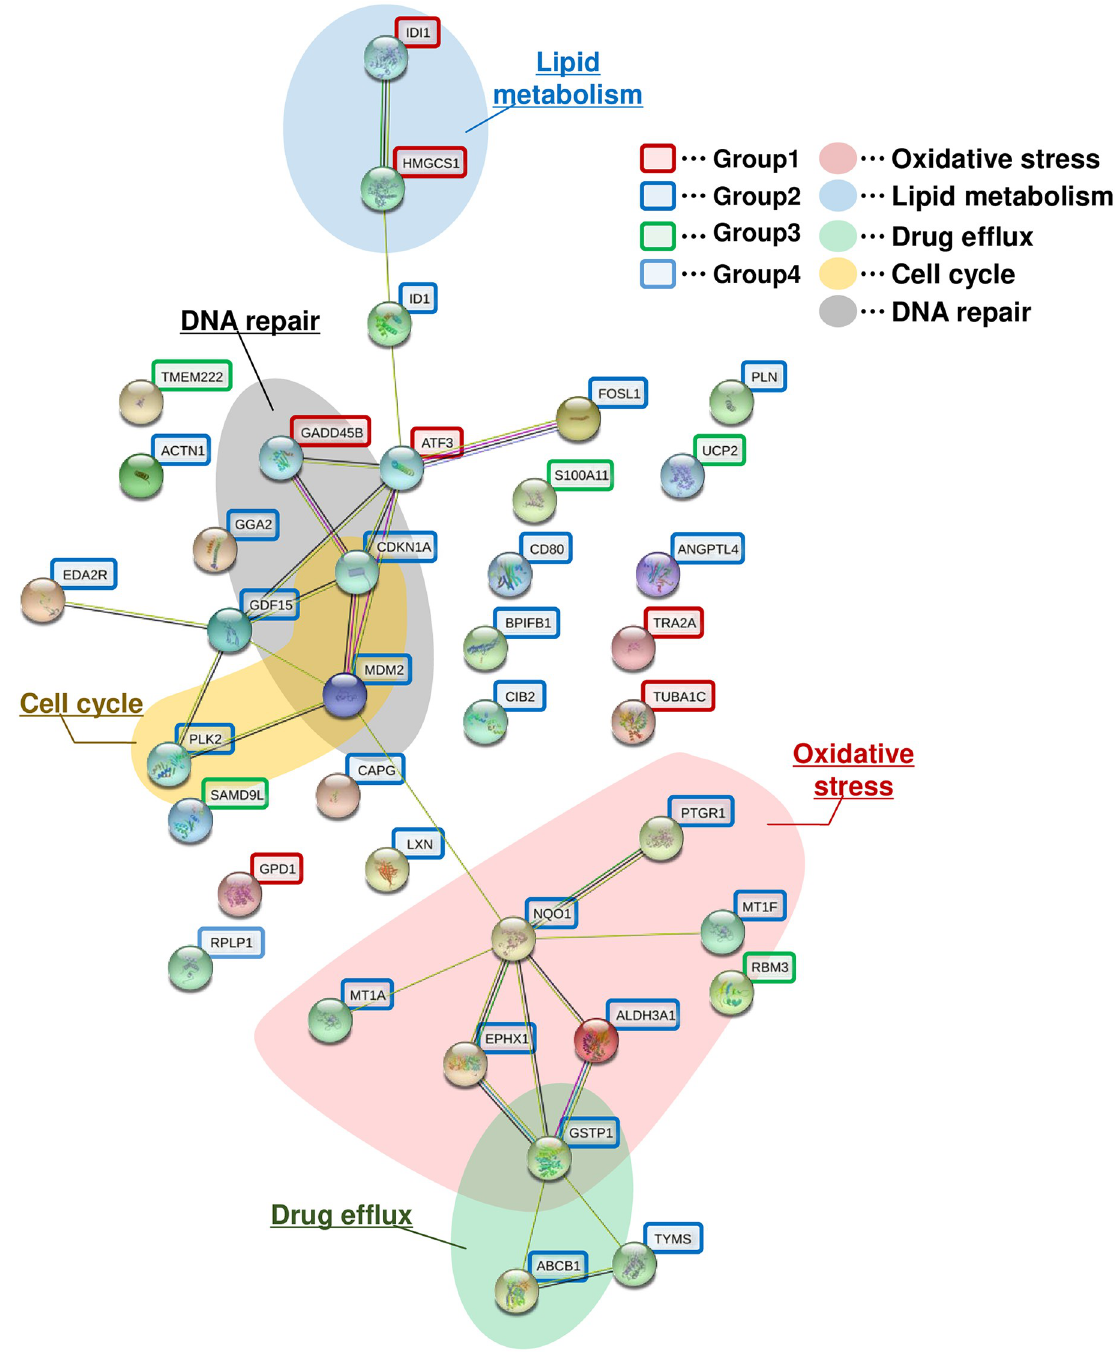
Fig 5. Functional protein association networks established by STRING. Functional protein association networks of 38 genes quantified over time during Days 1–4 of MMS treatment were generated using STRING analysis. Genes belonging to Groups 1, 2, 3, and 4 are circled in red, blue, green, and yellow, respectively. Areas where multiple genes related to oxidative stress, lipid metabolism, drug efflux, cell cycle, and DNA repair were clustered together and were filled with red, blue, green, yellow, and gray, respectively.